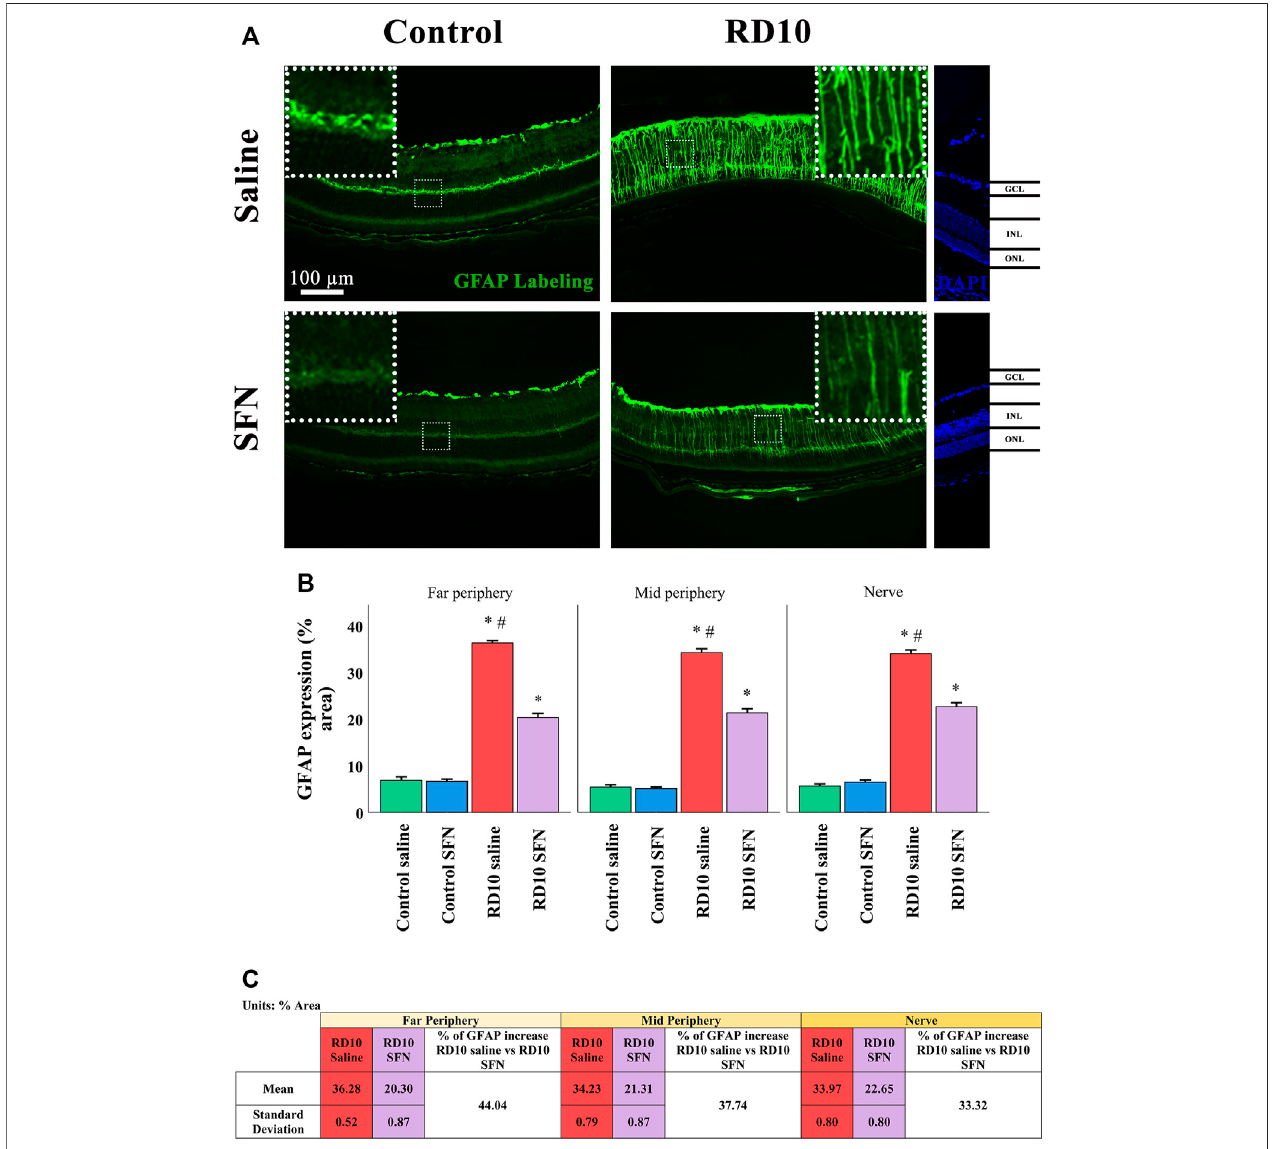
FIGURE 4 | GFAP cellular analysis. (A) Nerve images of GFAP immuno fl uorescence of the different groups in the experiment. (B) GFAP percentage. *Differences between Control Saline vs. RD10 Saline or Control SFN vs. RD10 SFN ( p -value < 0.05). #Differences between RD10 Saline vs. RD10 SFN ( p -value < 0.05). (C) Effect of SFN on RD10 mice GFAP mark expressed by the mean, standard deviation of the RD10 groups, and percentage reduction of RD10 SFN vs. RD10 Saline.